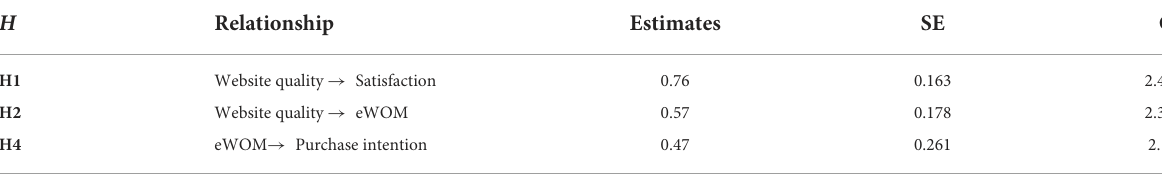
TABLE 5 SEM result.